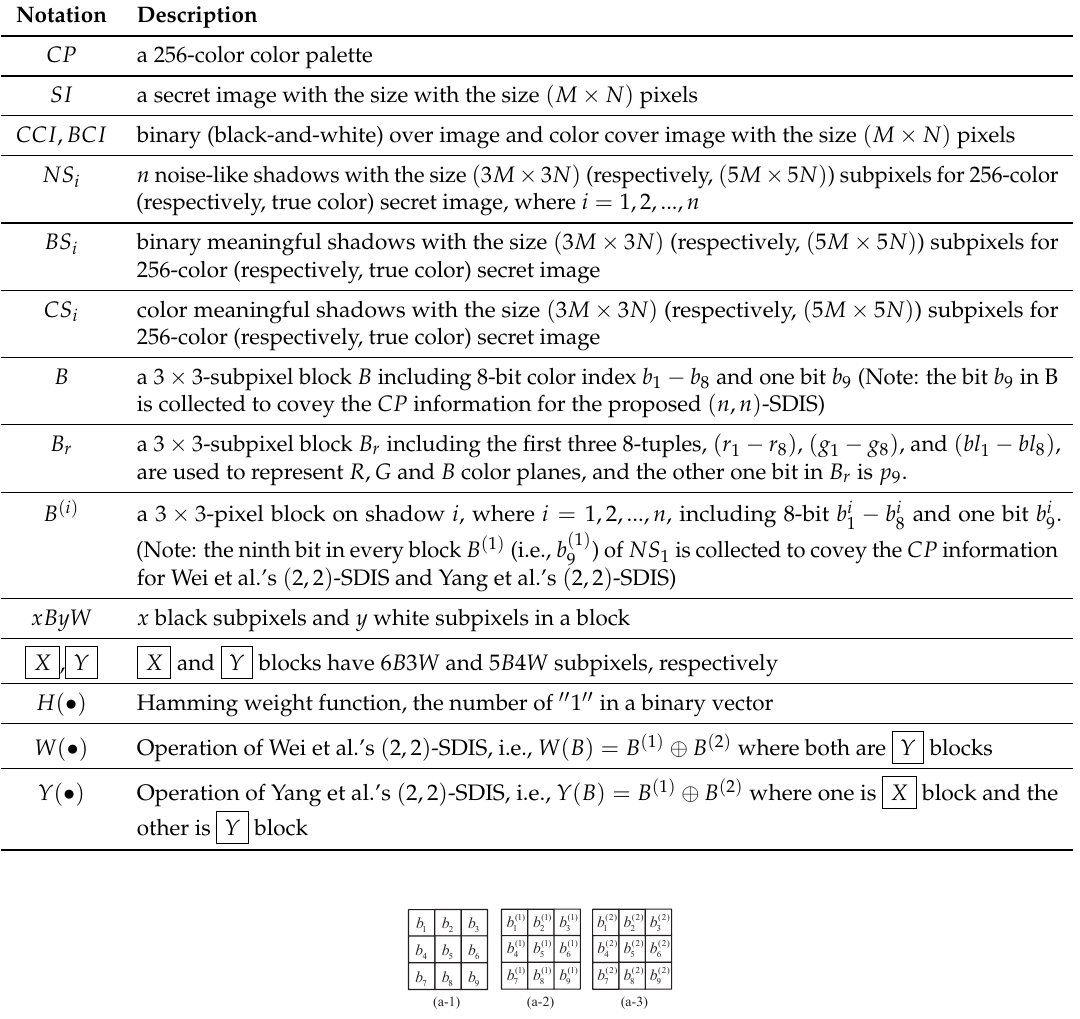
Table 1. Notations and Descriptions.